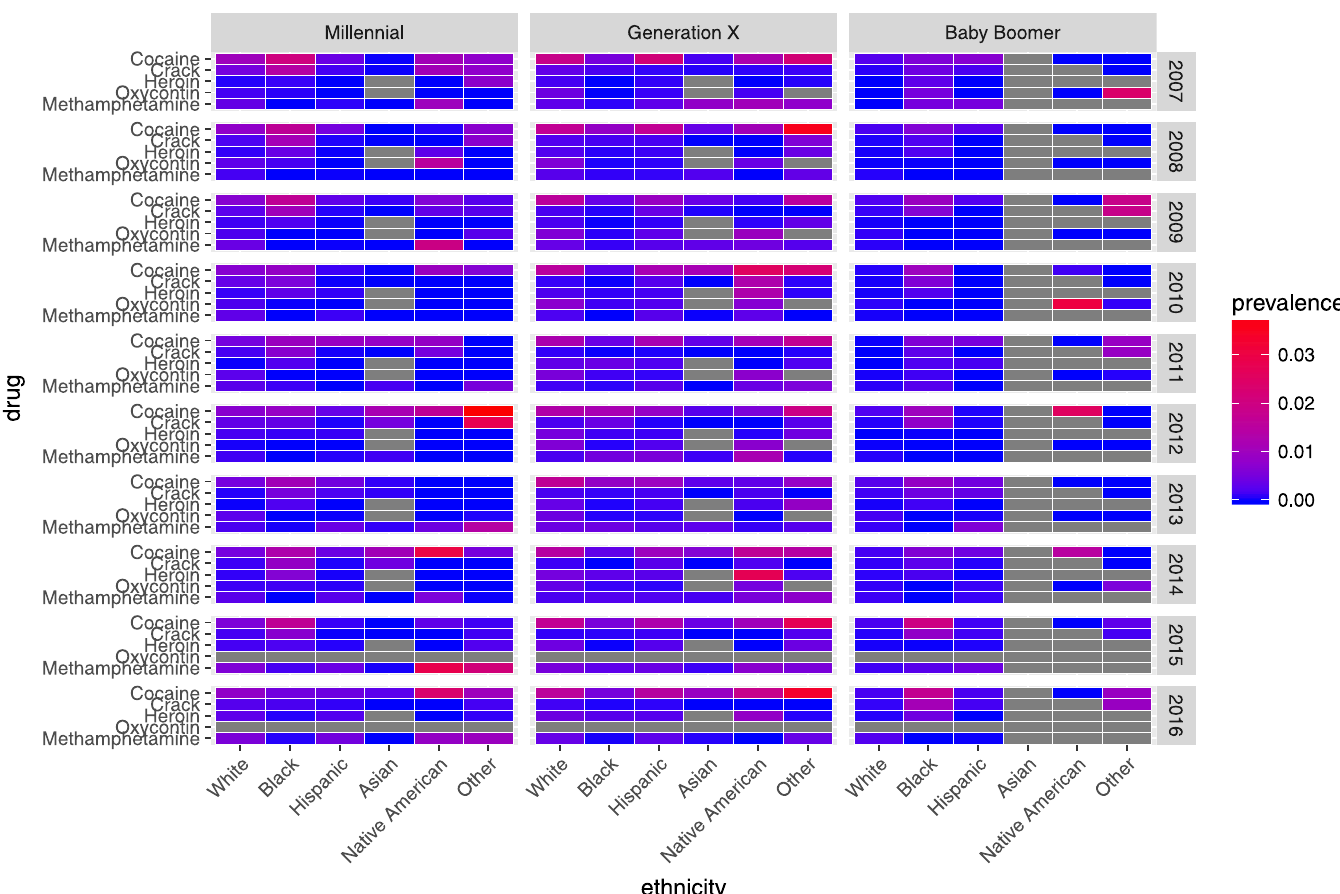
Fig 4. Patterns in prevalence of substance use by generational cohort and ethnicity, 2007–16. Grey cells denote missing data.